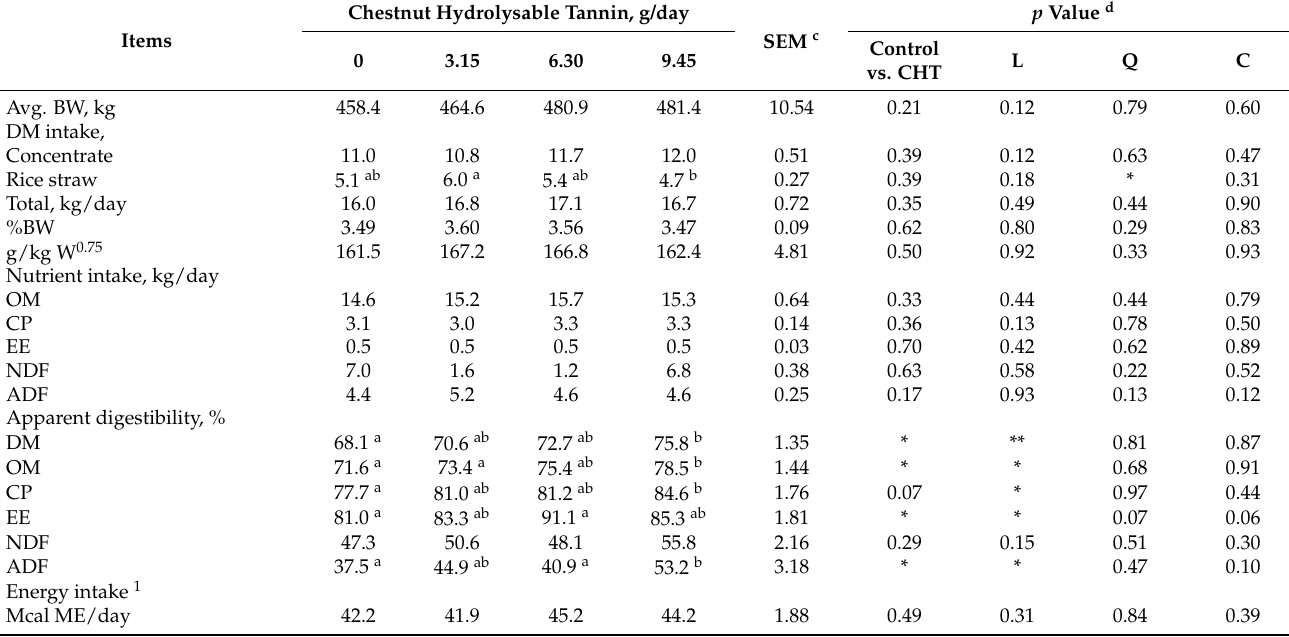
Table 2. Nutrient intake and digestibility in lactating dairy cows supplemented with various levels of chestnut hydrolysable